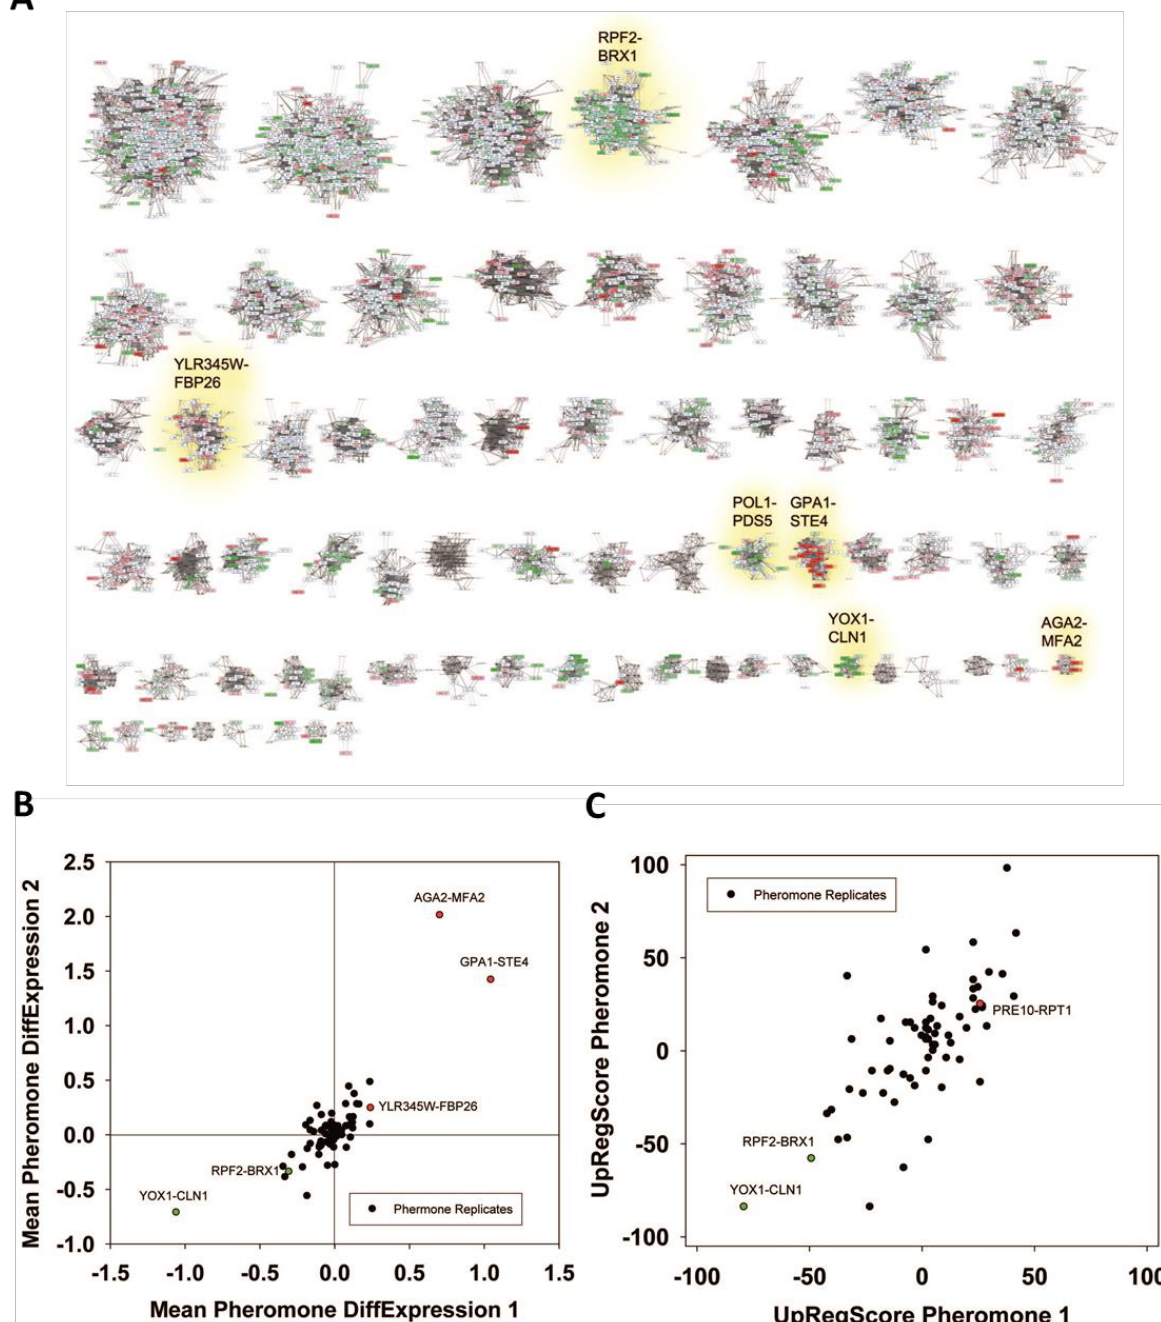
FIGURE 2: Analysis of microarray data sets on pheromone response. (A) Response to α -pheromone with data from [37]. Downregulation is shaded in four levels of green, upregulation in four levels of red. Genes, which are in the clustered network, but received no values in the experiment, were blanked out. Significantly changed cliques in replicate 1 are highlighted with yellow background and labelled with their clique name. (B) Comparison between two replicates in respect to average expression changes in the 72 cliques. We marked the cliques that are significantly changed in respect to average expression in both experiments (p<0.0001) in the plot with red (upregulation) and green (down- regulation) and labelled them accordingly. (C) UpRegScore for each cluster in the two replicates. Cliques, where both replicates showed sig- nificant shifts in the same direction were labelled in red (upregulation) or green (downregulation). We named them